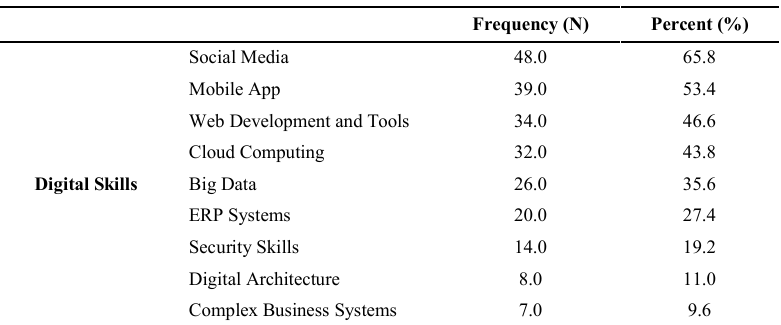
Table 11. Digital Skills.